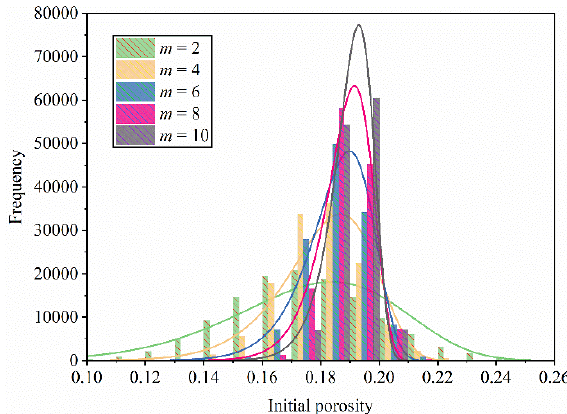
Figure 17. Initial porosity statistics with different homogeneity coefficients.